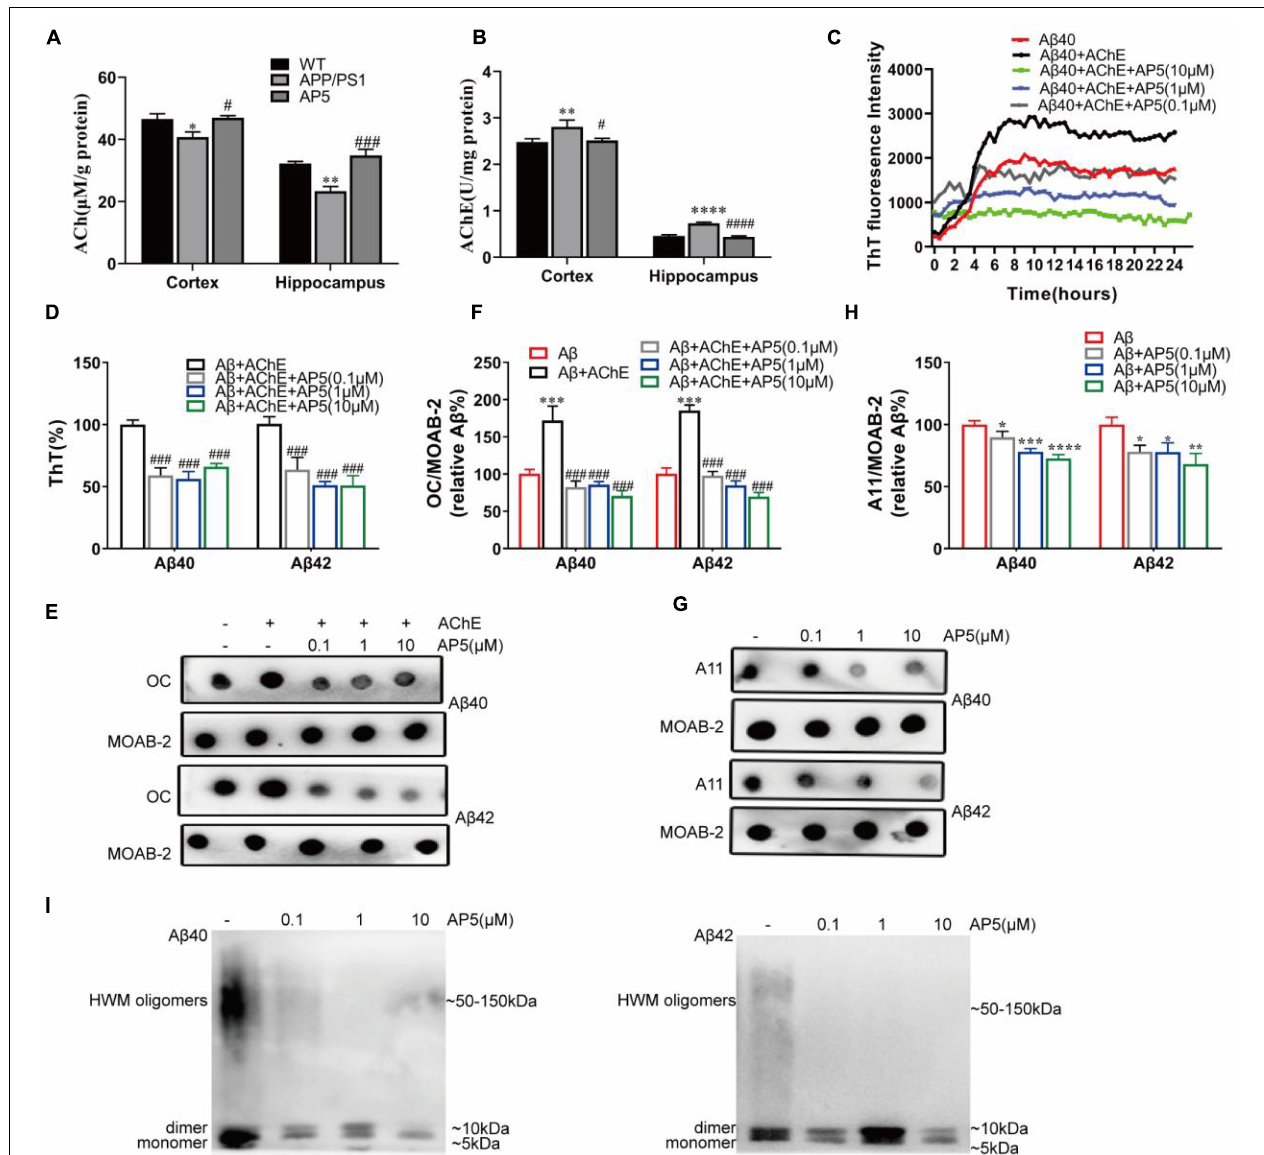
FIGURE 2 | AP5 inhibits AChE activity and blocks AChE-induced A β fibrillization and self-oligomerization. (A) The AChE activity and (B) ACh levels of the cortex and hippocampus from WT, APP/PS1, and AP5 mice. ∗ P < 0.05, ∗∗ P < 0.01, ∗∗∗∗ P < 0.0001 compared with WT mice, # P < 0.05, ### P < 0.001, #### P < 0.0001 compared with APP/PS1 mice by one-way ANOVA followed by a Turkey’s post hoc test, n = 6 mice per group. (C) The ThT assessment of AChE-induced A β 40 fibril formation kinetics during 24 h. Triple replicates per group at each time point. (D) The disaggregation assessment on pre-formed A β 40- and A β 42-AChE fibrils complex using ThT binding. Triple replicates per group. (E) Dot blot images and (F) quantification of pre-formed A β 40-and A β 42-AChE fibrils complex with or without AP5 using an amyloid fibrils-specific antibody (OC). Triple replicates per group. (G) Dot blot images and (H) quantification of A β 40 and A β 42 oligomers with or without AP5 using an oligomer-specific antibody (A11). ∗ P < 0.05, ∗∗ P < 0.01, ∗∗∗ P < 0.001 compared with A β alone, ### P < 0.001 compared with A β + AChE group by one-way ANOVA followed by a Turkey’s post hoc test, triple replicates per group. (i) Immunoblot analysis of A β 40 (left)and A β 42 (right) oligomers with